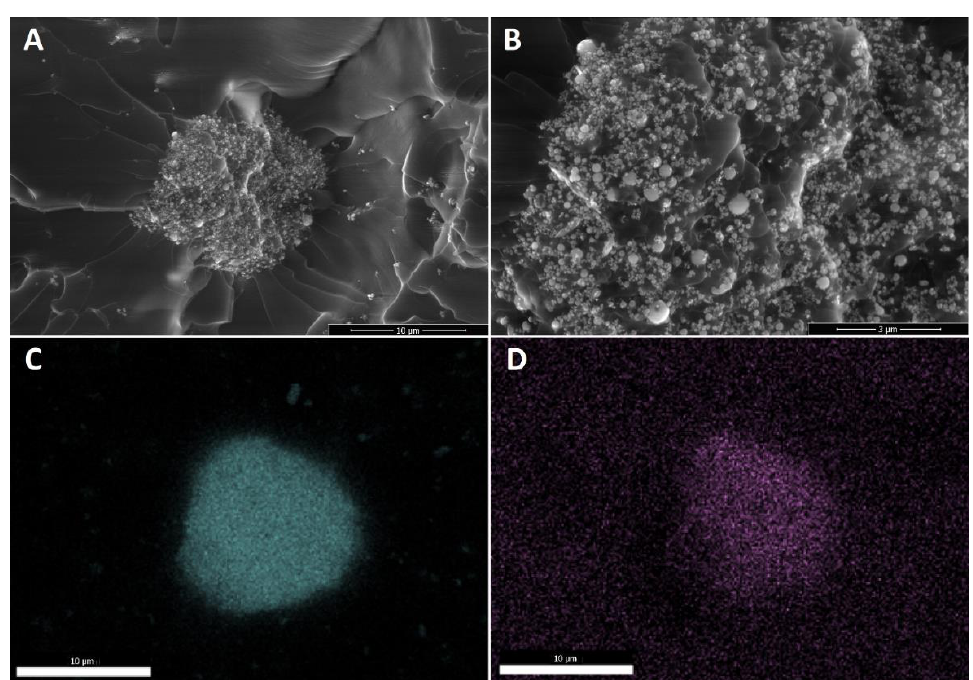
Figure 6. Microdroplets of condensed SS-6GP-2TMOS together with TiO 2 particles visible for 1Ti15SS-6GP-2TMOS. ( A )—10,000× magnification; ( B )—30,000× magnification; ( C )—titanium (Ti) EDS; ( D )—silicon (Si) EDS. Table 3. Water contact angles of TiO 2 modified with the studied silane coupling agents.